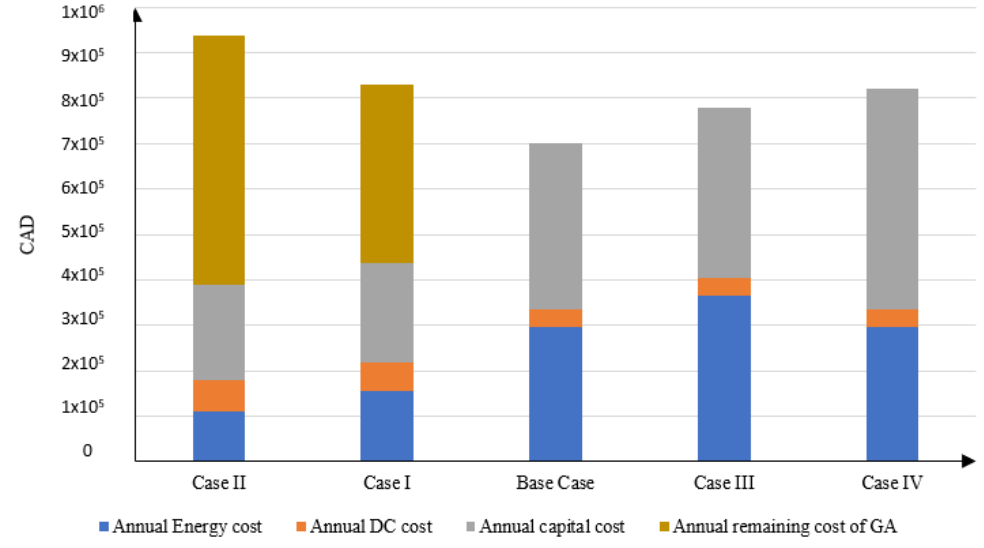
Figure 13. Results of the C-rate sensitivity case study in terms of the cost components.